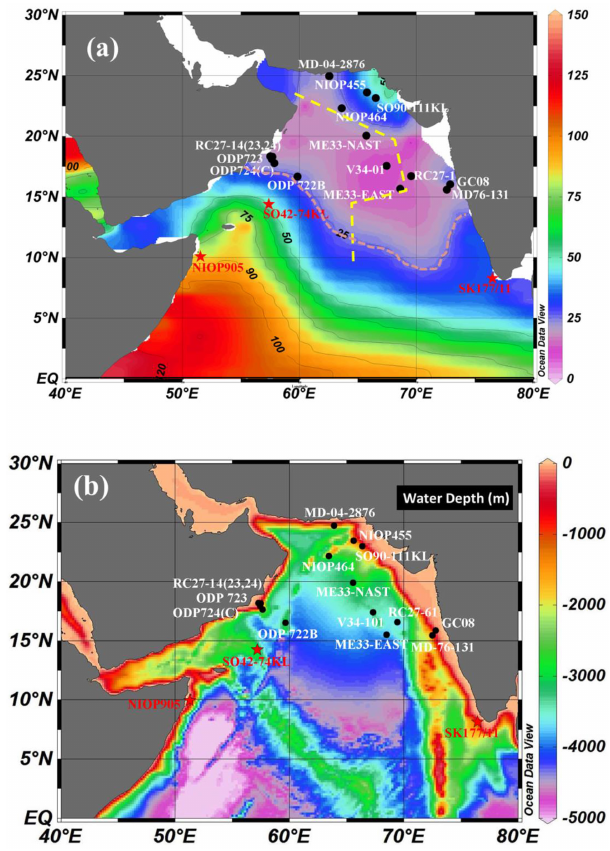
Figure 1. (a) Map of the Arabian Sea. Dissolved oxygen (DO) con- centration at 150m (World Ocean Atlas 09) was shown in color contour. Southern ( (cid:63) ) and northern ( • ) categories of available cores and SK177/11, in this study, were defined by DO of 25µmolkg − 1 (see text; purple dash curve). (b) Bathymetric map superimposed by core locations; (c) , (d) and (e) are DO, nitrate and N ∗ transects (yellow dashed line in (a) , online data originated from cruises of JGOFS in 1995), respectively, for upper 2000m. (f) N ∗ transect for the upper 300m with arrows revealing the flow direction. In (a) , the northern cores include core MD-04-2876 (828m; Pichevin et al., 2007), core NIOP455 vs. NIOP464 (1002m vs. 1470m; Reichart et al., 1998), SO90-111KL vs. ME33-NAST(775m vs. 3170m; Suth- hof et al., 2001), ODP724C vs. ME33-EAST (603m vs. 3820m; Möbius et al., 2011), RC27-24 vs. RC27-61 (1416m vs. 1893m; Altabet et al., 1995), ODP723, ODP722(B) vs. V34-101 (808m, 2028m vs. 3038m; Altabet et al., 1999), RC27-14 vs. RC27-23 (596m vs. 820m; Altabet et al., 2002), GC08 (2500m; Banakar et al., 2005), MD-76-131 (1230m; Ganeshram et al., 2000); the south- ern cores include core SO42-74KL (3212m; Suthhof et al., 2001), NIOP905 (1586m; Ivanochko et al., 2005) and SK177/11 (776m; this